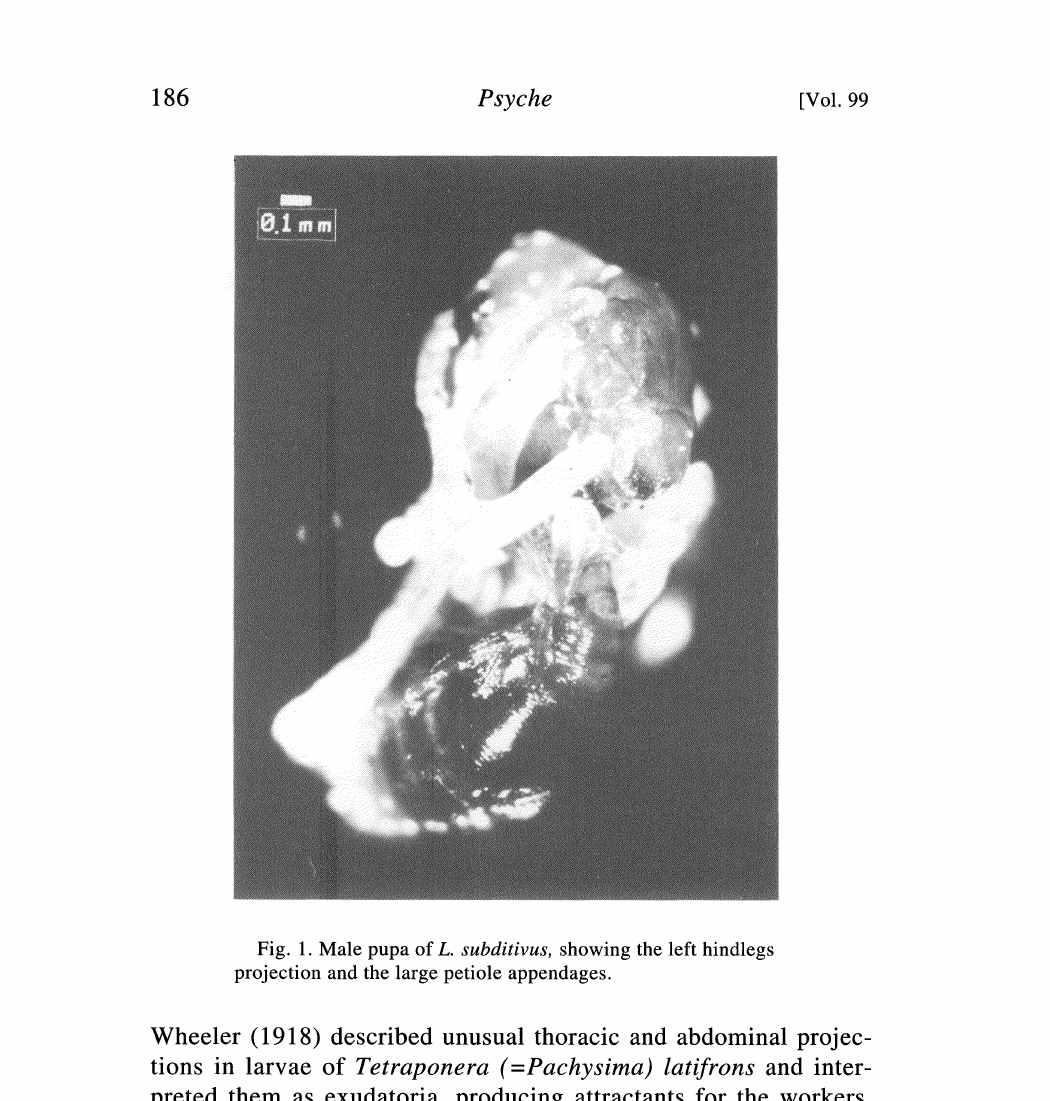
Fig. 1. Male pupa of L. subditivus, showing the left hindlegs projection and the large petiole